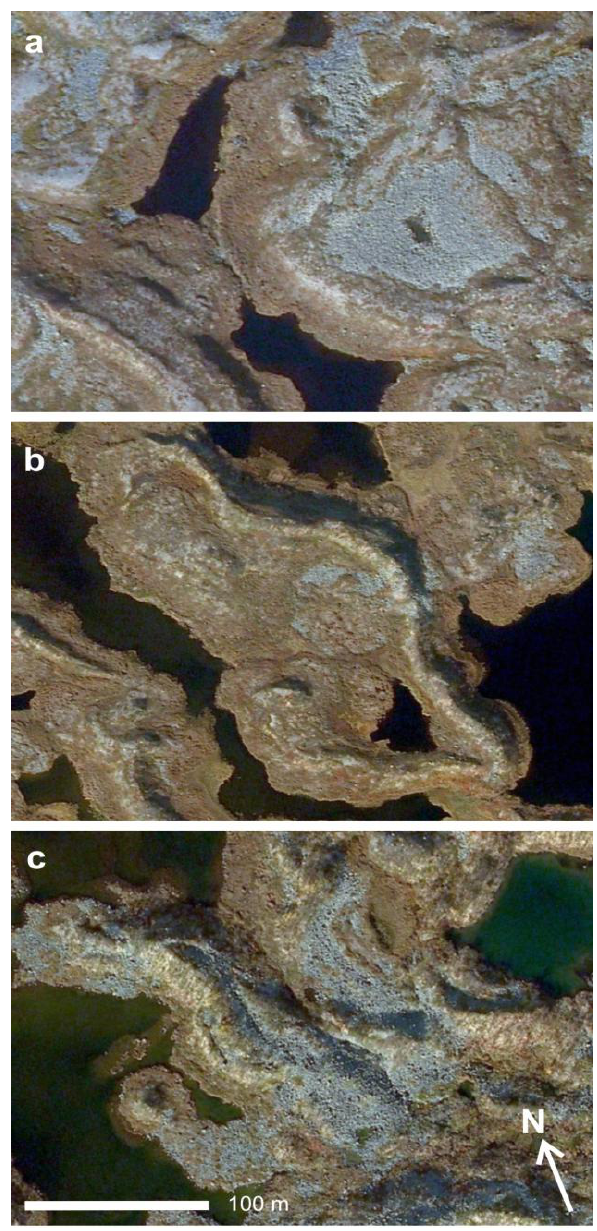
Figure 5. Air photos (Norkart Geoservice AS and Geovekst) show- ing examples of surface stoniness of the Maskevarri Ráhppát, Finn- mark, northern Norway. Locations indicated in Fig.